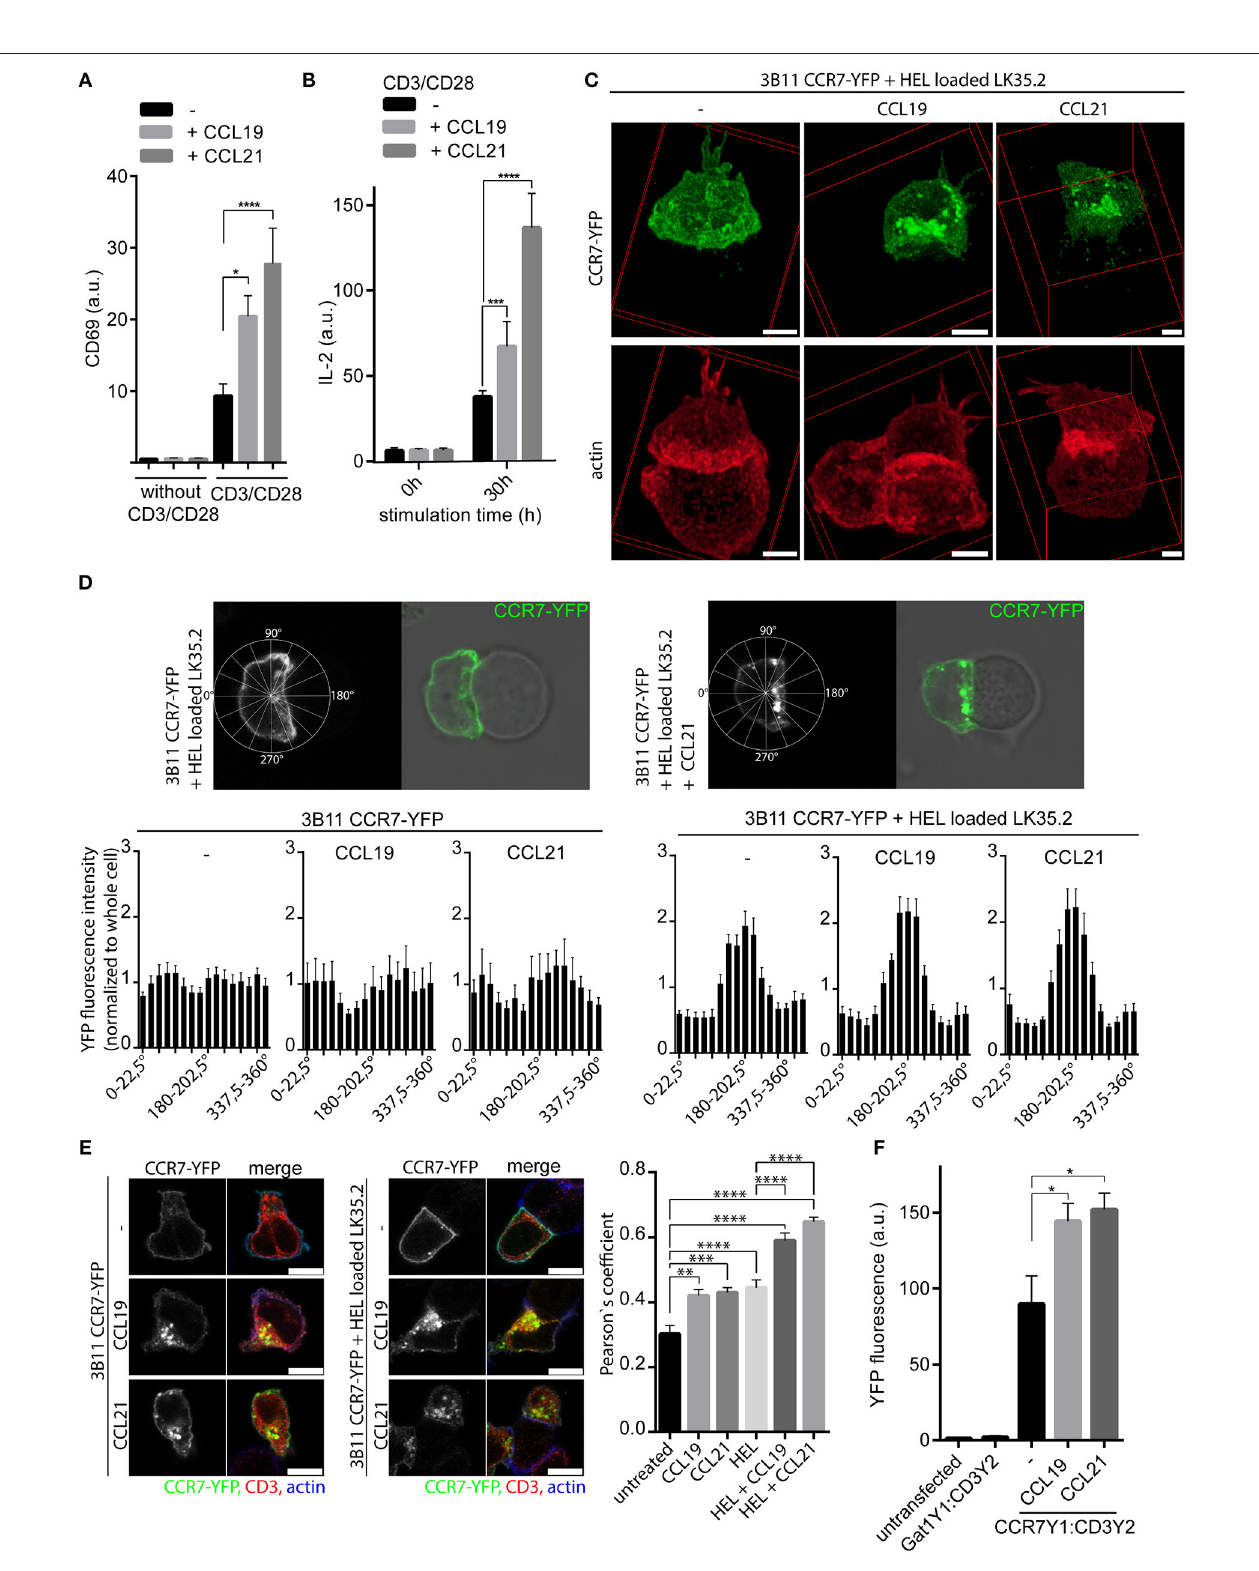
FIGURE 1 | CCR7 acts as co-stimulatory molecule and is recruited to the immunological synapse . (A) Quantification of CD69 surface expression on human PBLs upon TCR stimulation using anti-CD3/CD28 coated beads and/or CCR7 stimulation (0.5 µ g/ml CCL19 or CCL21) for 20h measured by flow cytometry. Mean ± SEM of four individual donors. (B) Intracellular IL-2 staining in human PBLs upon TCR and/or CCR7 stimulation for 30h measured by flow cytometry. Mean ± SEM of four